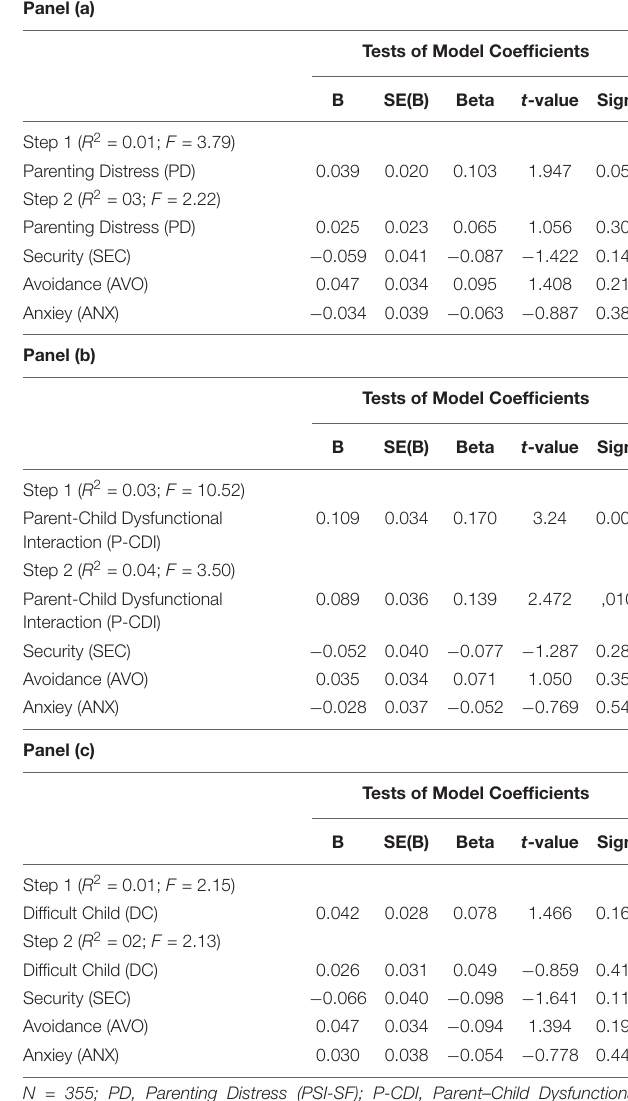
TABLE 4 | Summary of hierarchical regression analysis for parenting stress and attachment styles to predict children’s social communication abilities. Panel